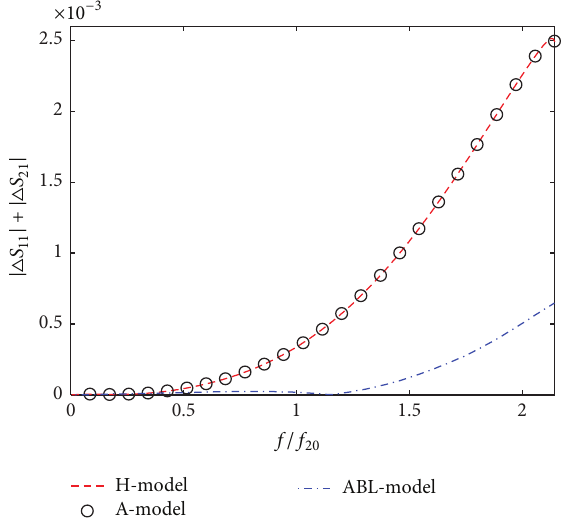
Figure 17: The 𝑆 -parameter differences at 𝜃 0 = 30 ∘ for three proposed models with angle-dependent parameters. Dashed-red curve: H-model; solid-black curve: A-model; dash-dotted-blue curve: